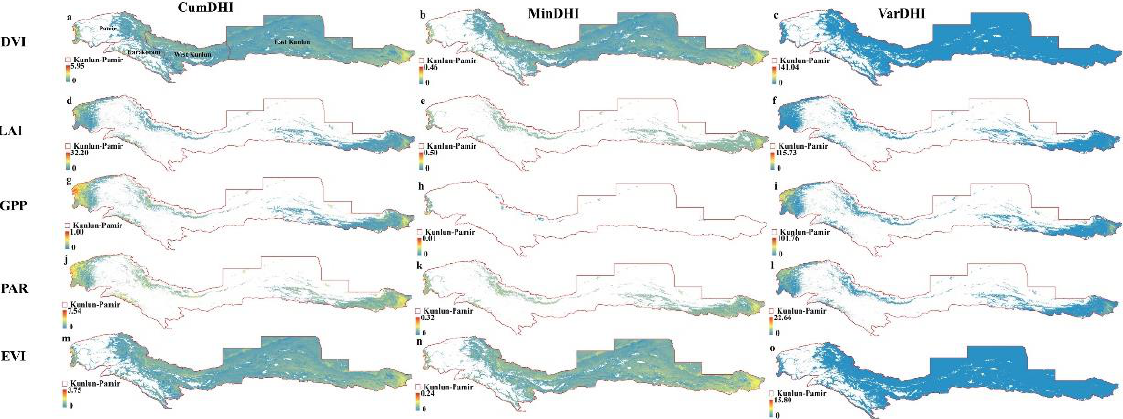
Figure 1. The spatial patterns of three DHIs derived from ( a – c ) the NDVI, ( d – f ) LAI, ( g – i ) GPP, ( j – l ) FPAR and ( m – o ) EVI.